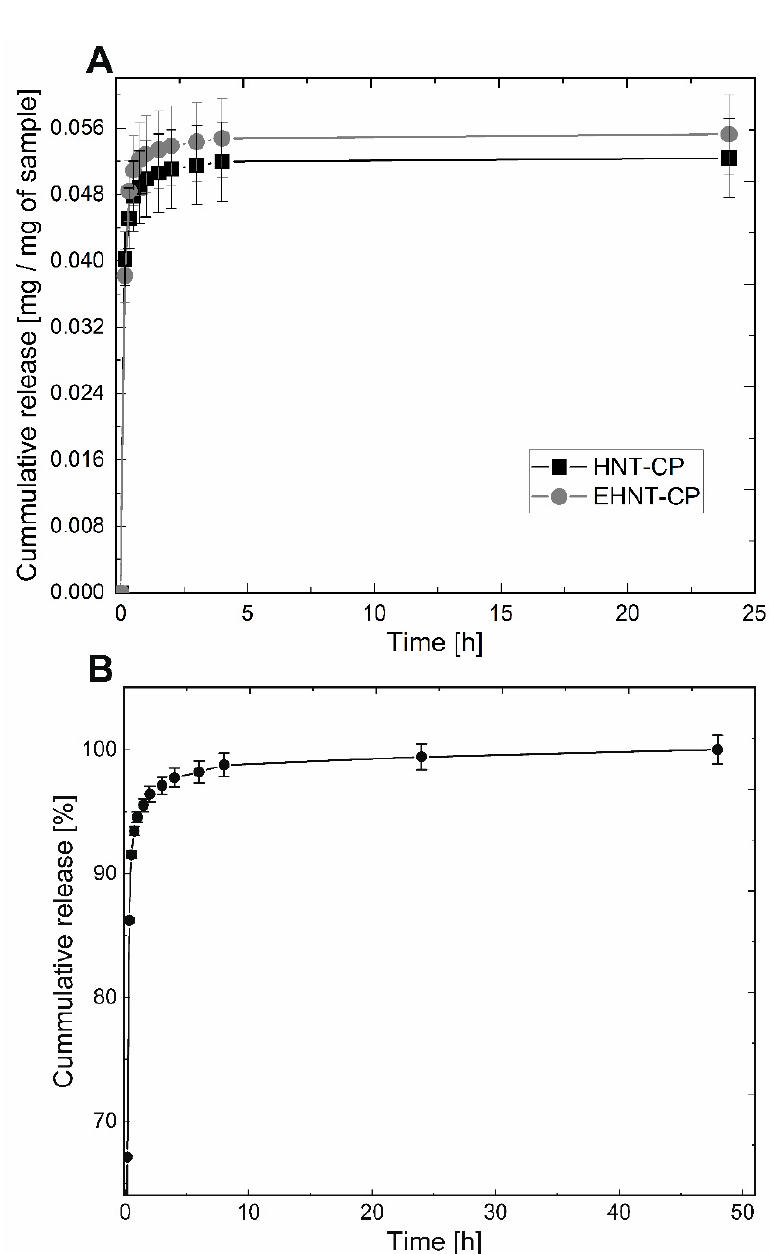
Figure 3. ( a ) Release profiles for HNT-CP and EHNT-CP; ( b ) extended-release profile for Figure 3. ( A ) Release profiles for HNT-CP and EHNT-CP; ( B ) extended-release profile for EHNT-CP.